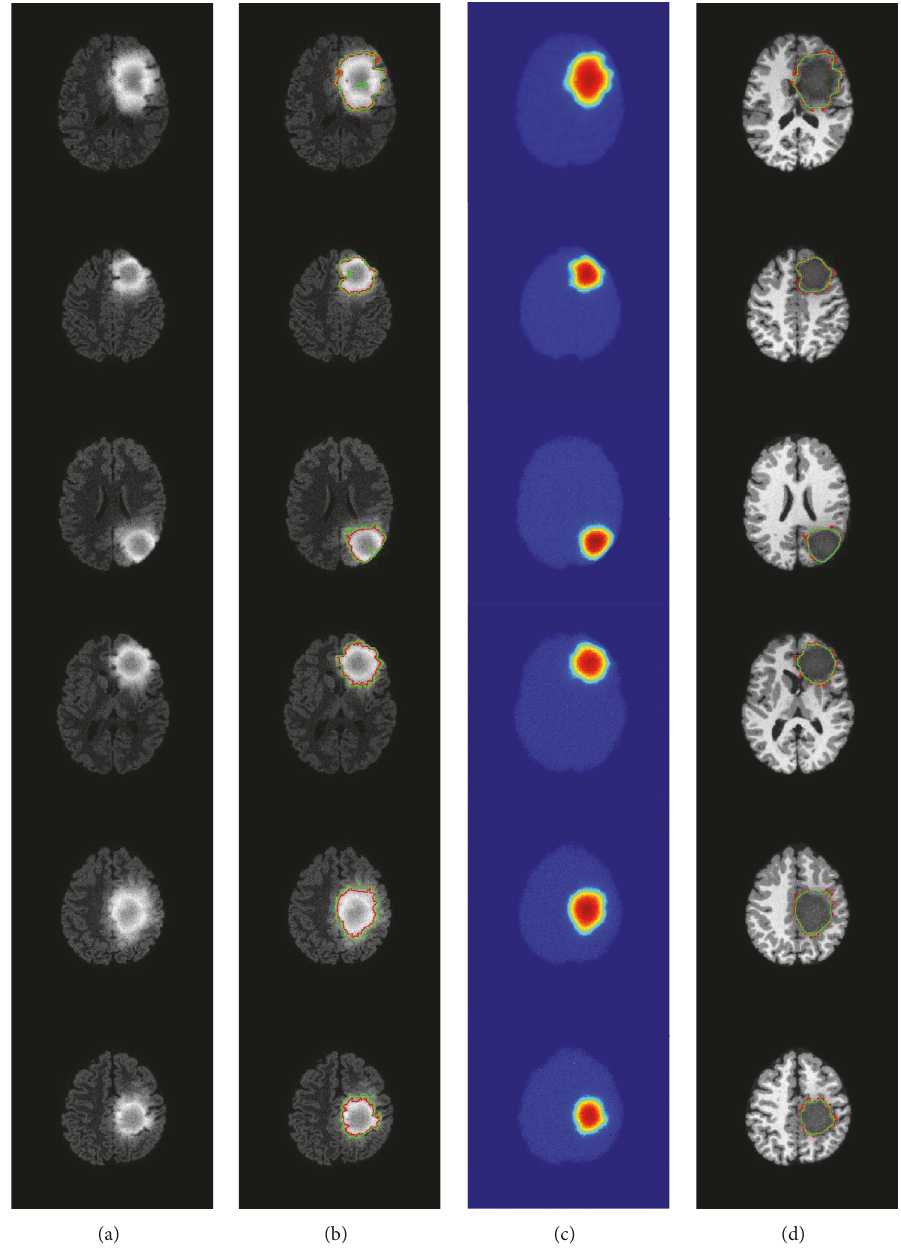
Figure 10: Results of segmentation by level set method in, MRI images and the proposed approach applied in six patients taken from BRATS 2013. (a) Flair images (c) segmentation by level set in Flair images. (c) Temperature distribution with noise (d) the segmentation using the proposed approach showed in T1-weighted images (green: segmentation, red: ground